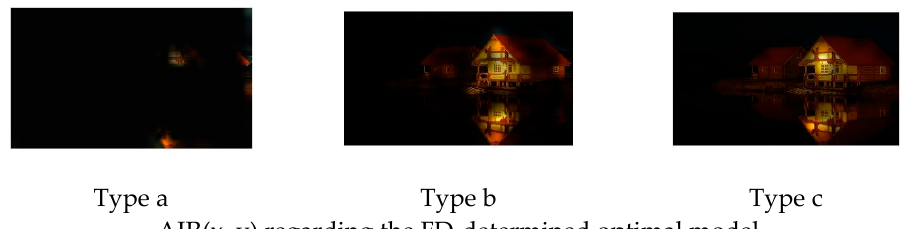
Figure 16. FFP(x, y) of Figure 15.